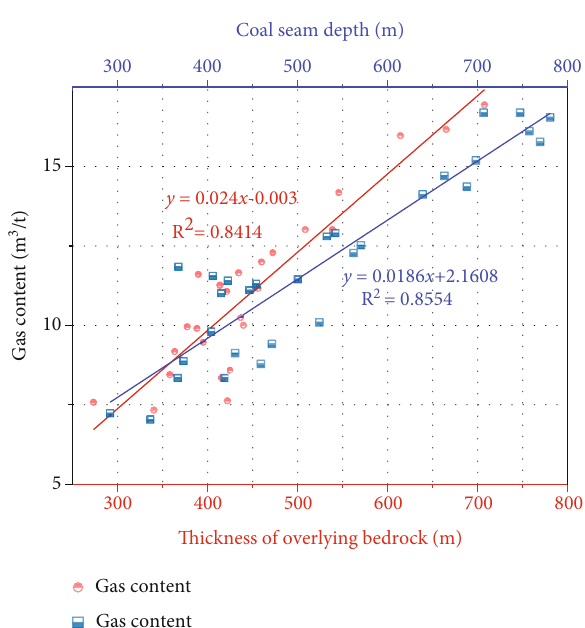
Figure 6: Coal seam distribution map.